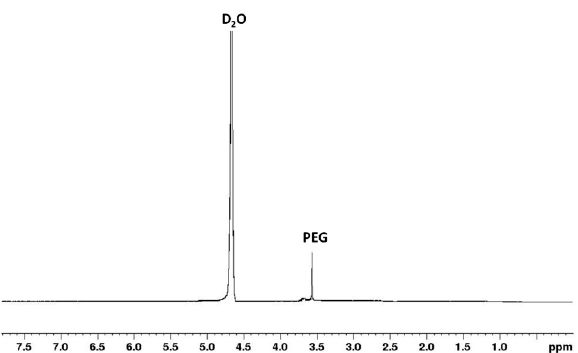
Figure 4. 1 H NMR spectrum (400 MHz, D 2 O, 298 K) of PCL-PEG-PCL micelles loaded with quercetin.